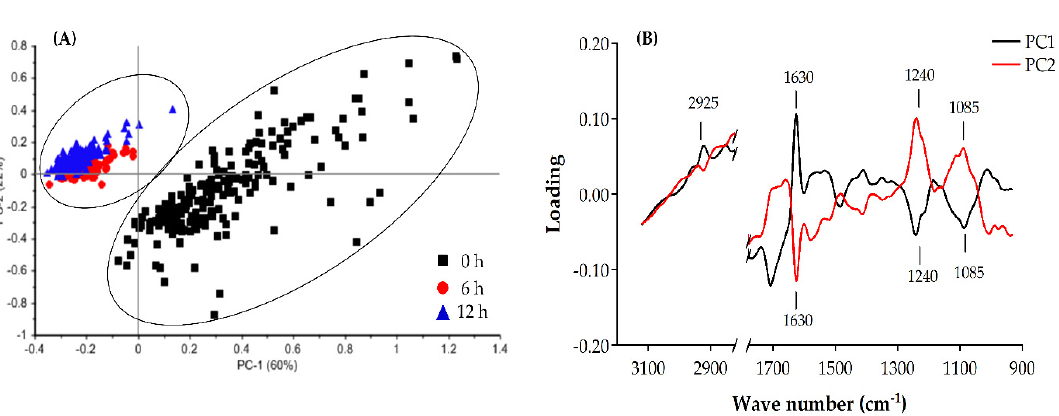
Figure 5. Scores plots ( A ) and loading plots ( B ) from PCA of the overall spectra data for B. cereus treated with 0.1% EOEP for 0, 6 and 12